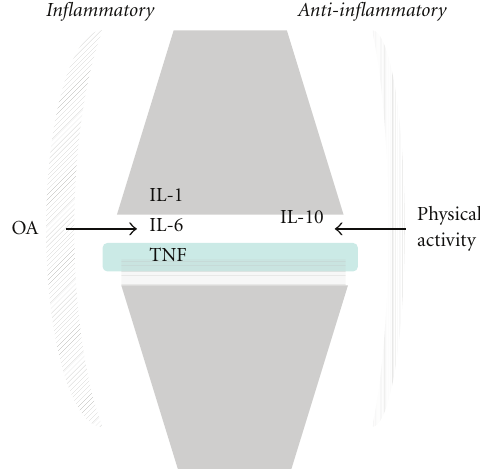
Figure 3: Cytokine expression at rest and during physical